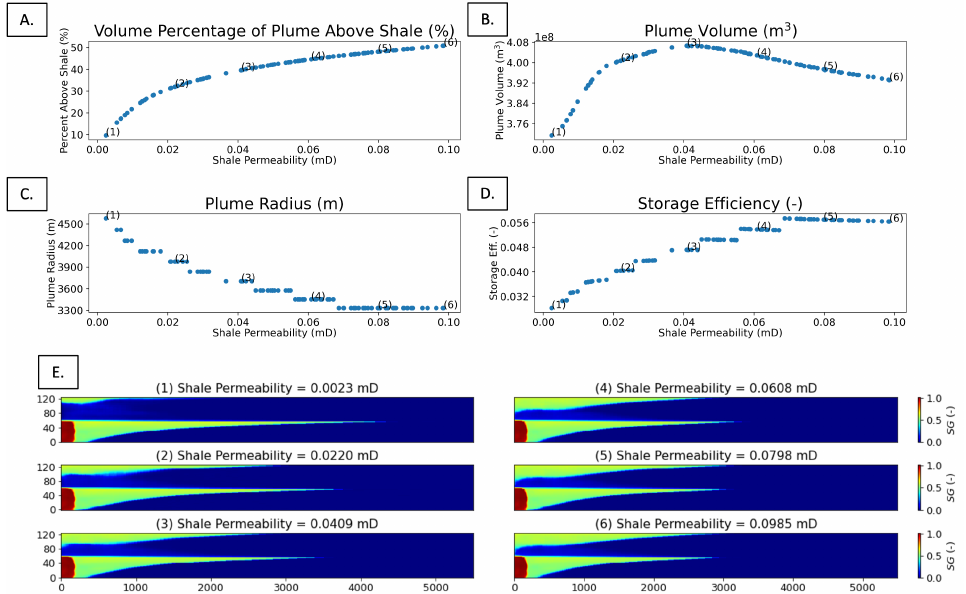
Figure 6. The impact of shale permeability on plume migration. ( A – D ) illustrate the relationship between four plume variables and the shale permeability. ( E ) shows the gas saturation map of six modeled cases (labeled in ( A – D